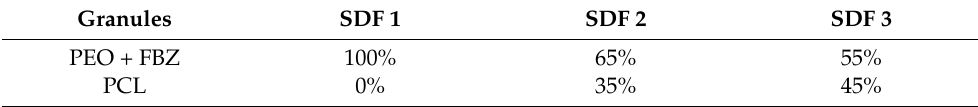
Table 2. Description of the composition in percentage ( w / w ) of the solid dispersion formulations. Granules SDF 1